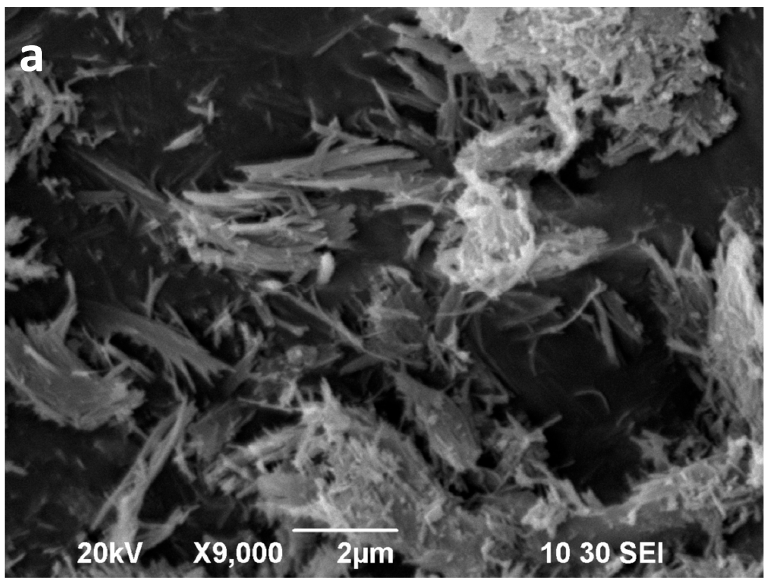
Figure 10. SEM images of the sepiolite Sp1 ( a ), sepiolite Sp1 after 16 min of microwave-assisted acid treatment ( b ).